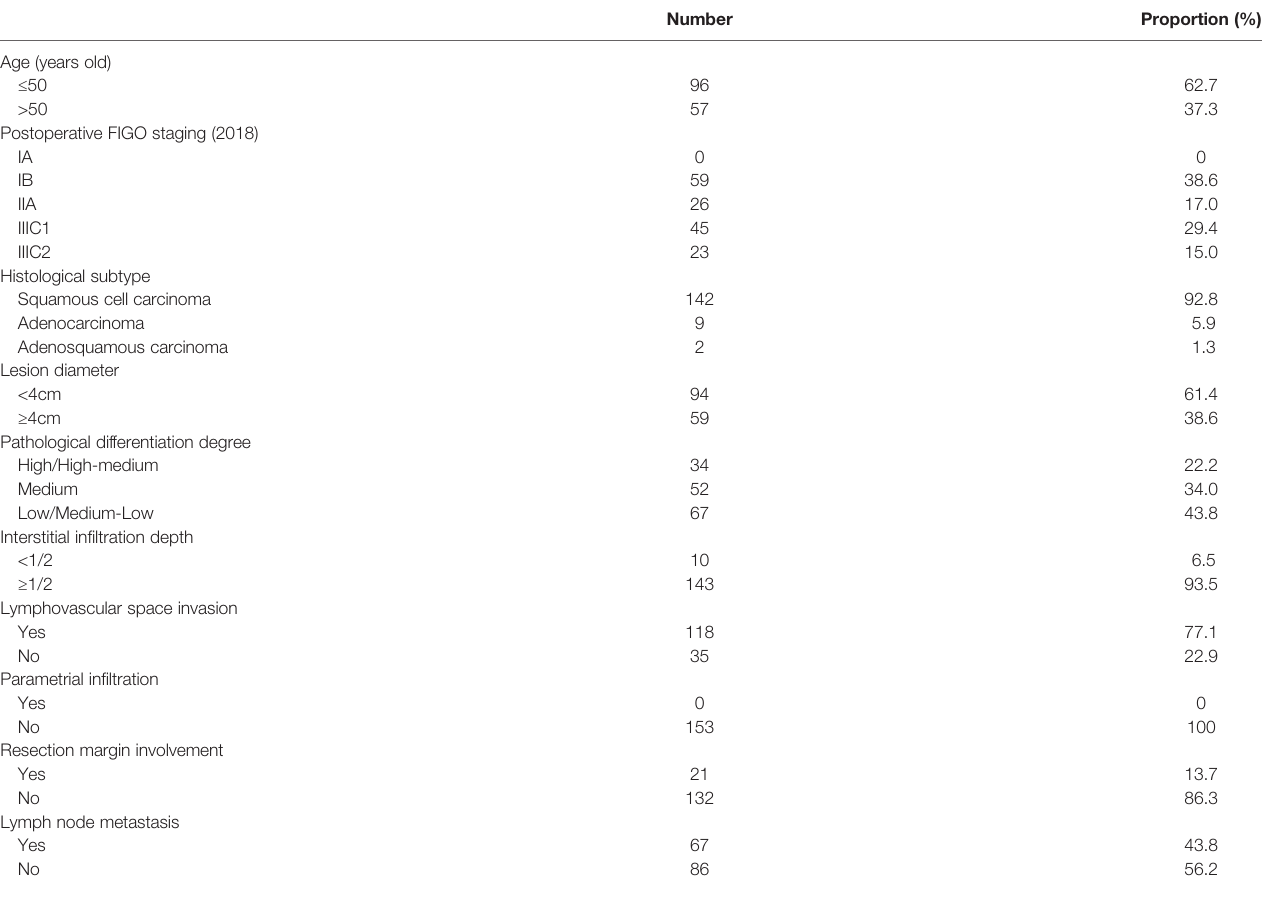
TABLE 1 | Basic characteristics of recurrent cervical cancer patients after initial